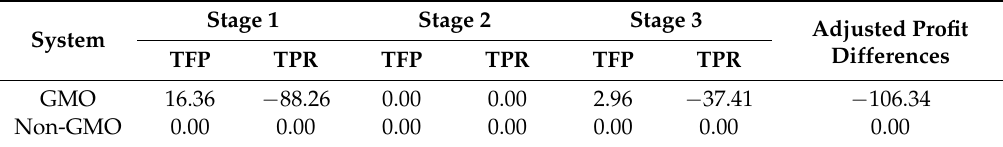
Table 6. Differences in the adjusted profit for GMO and non-GMO systems.